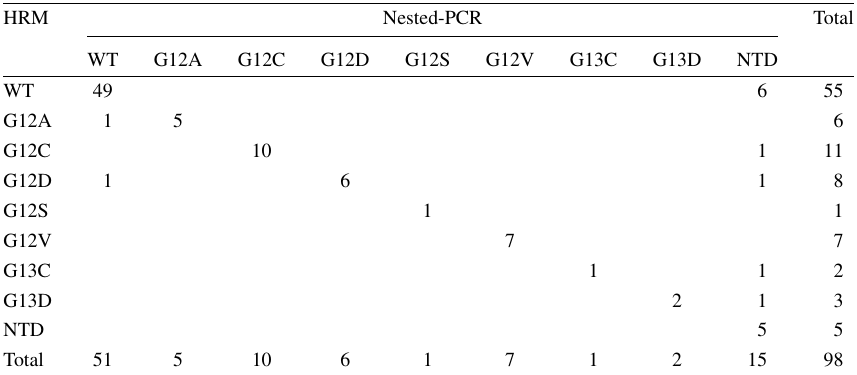
Comparison of genotype findings of HRM and nested-PCR assays HRM